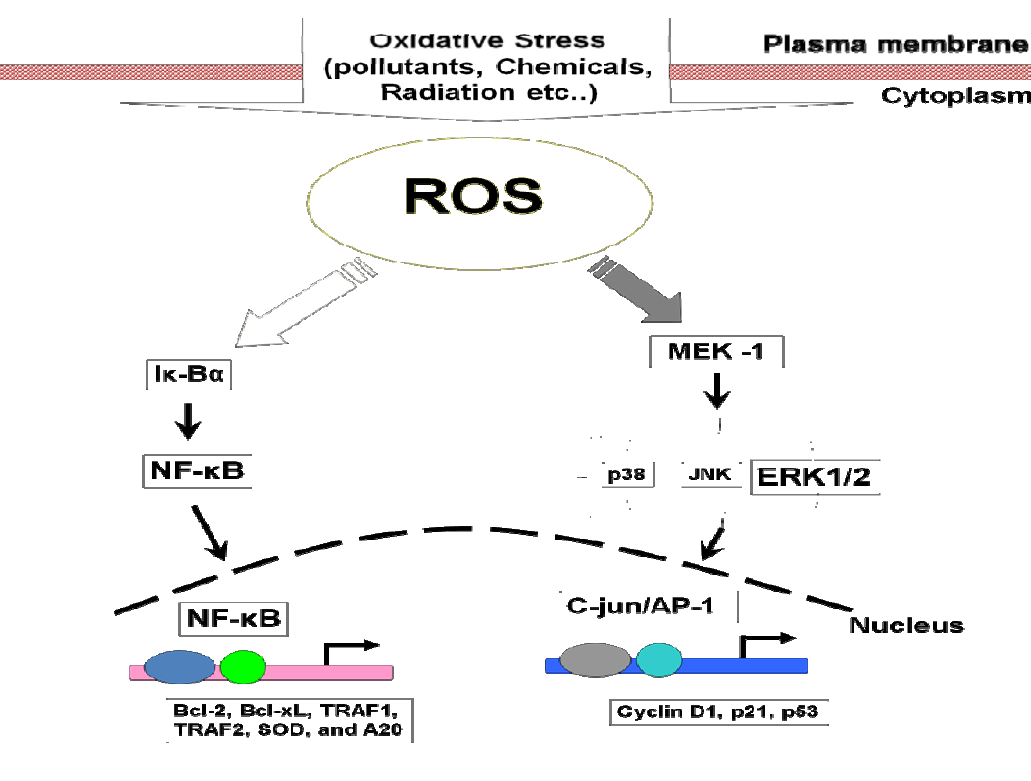
Figure 2 . ROS mediated activation of cell signaling